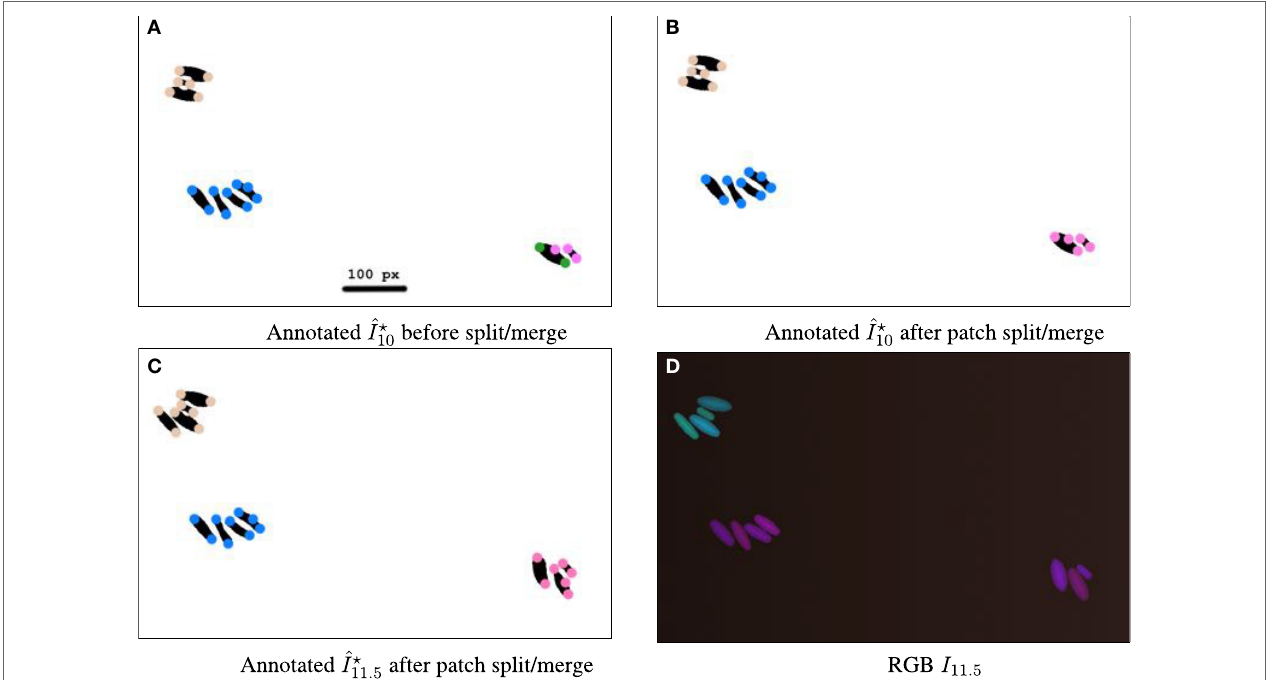
Figure 8 | Sequence illustrating the split/merge computation with simulated movie DS5, designed to allow patches to be verifiable by the naked eye from the RGB image. Simulated movie DS5 is available from the study by Wiesmann et al. (2017). Images are cropped to a 787 × 482 px subset. (a–c) Binary images are annotated with colored circles, 16 px wide. The color encodes the patch ID. The geometric distance threshold for patch construction is set stringently to 100 px. (a) At time 10 h, before split/merge computation, showing four current patches. The bottom right quadrant has two neighboring cells with differently colored particles showing current assignments to different patches. (B) After split/merge computation, the particles are indeed the same color, showing that the patches have been merged as the patches are within the threshold distance to each other and have similar fluorescence. (c) At time 11.5 h, both the top left patch and the bottom right patch have new cells, and after the split/merge procedure is run for this time point they have correctly been assigned to the correct patch. (D) RGB image at time 11.5